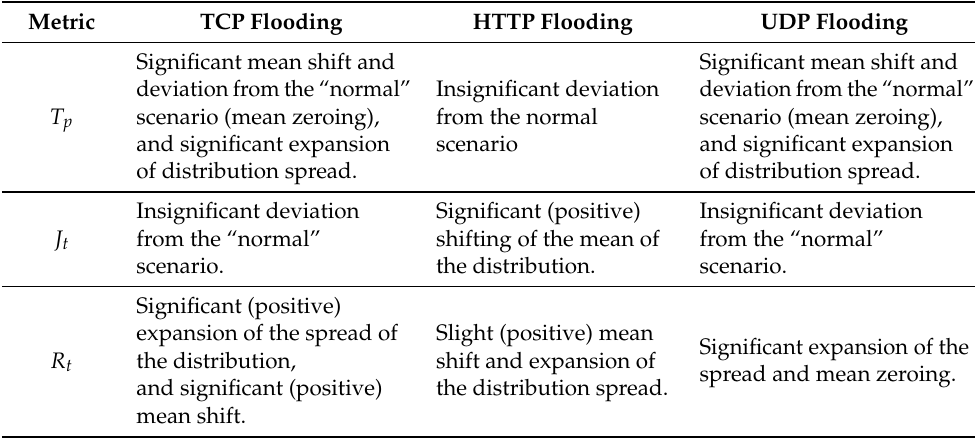
Table 12. Summarized EDA-based qualitative assessment of SDN metrics.